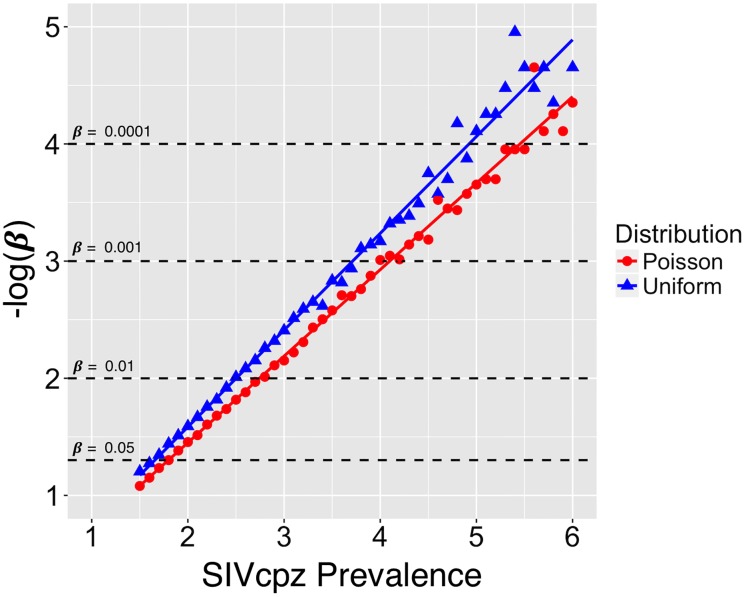
Simulation results estimating ß, the likelihood of erroneously concluding the virus is absent, for a given average prevalence of SIVcpz.Since a single SIV+ case would refute the hypothesis of zero prevalence, ß is equal to the proportion of times zero SIV+ cases are returned when in fact the virus is present. For the uniform distribution (plotted in blue), each data point represents -log10 of the proportion of 90,000 simulations returning zero SIVcpz positive cases, assuming each sample site has the same underlying prevalence. For simulations of the Poisson distribution (plotted in red), prevalence is equal to the λ parameter. For each run, sample site prevalence were randomly assigned from sampling the Poisson distribution with a particular λ. A total of 5,000 independent Poisson samples were taken, and the proportion of times zero SIVcpz-positive cases was estimated from 18 binomial sampling runs. Thus, each data point represents the -log10 of the proportion of 90,000 simulations returning zero SIVcpz positive cases.